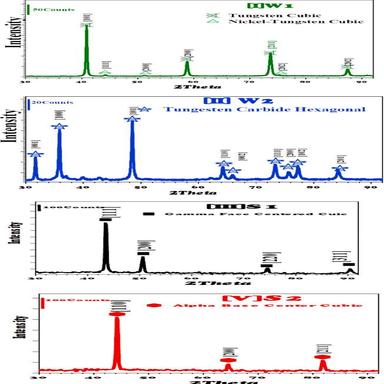
X-ray diffraction patterns for the W1, W2, S1 and S2 investigated alloys.